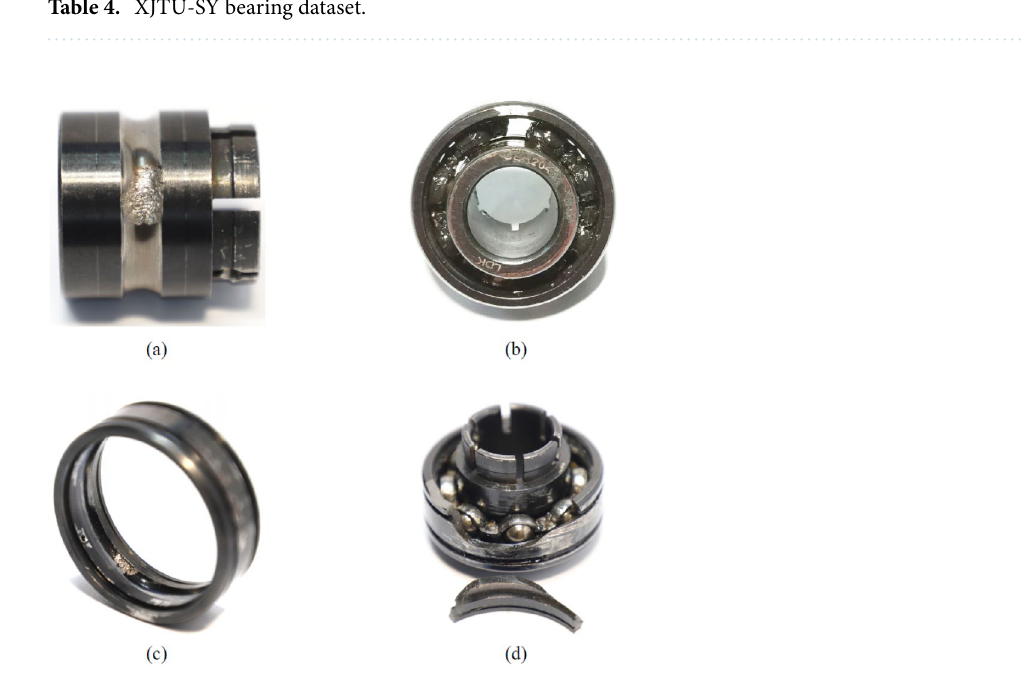
Figure 13. Failure bearings: ( a ) inner race wear; ( b ) cage fracture; ( c ) outer race wear; ( d ) outer race